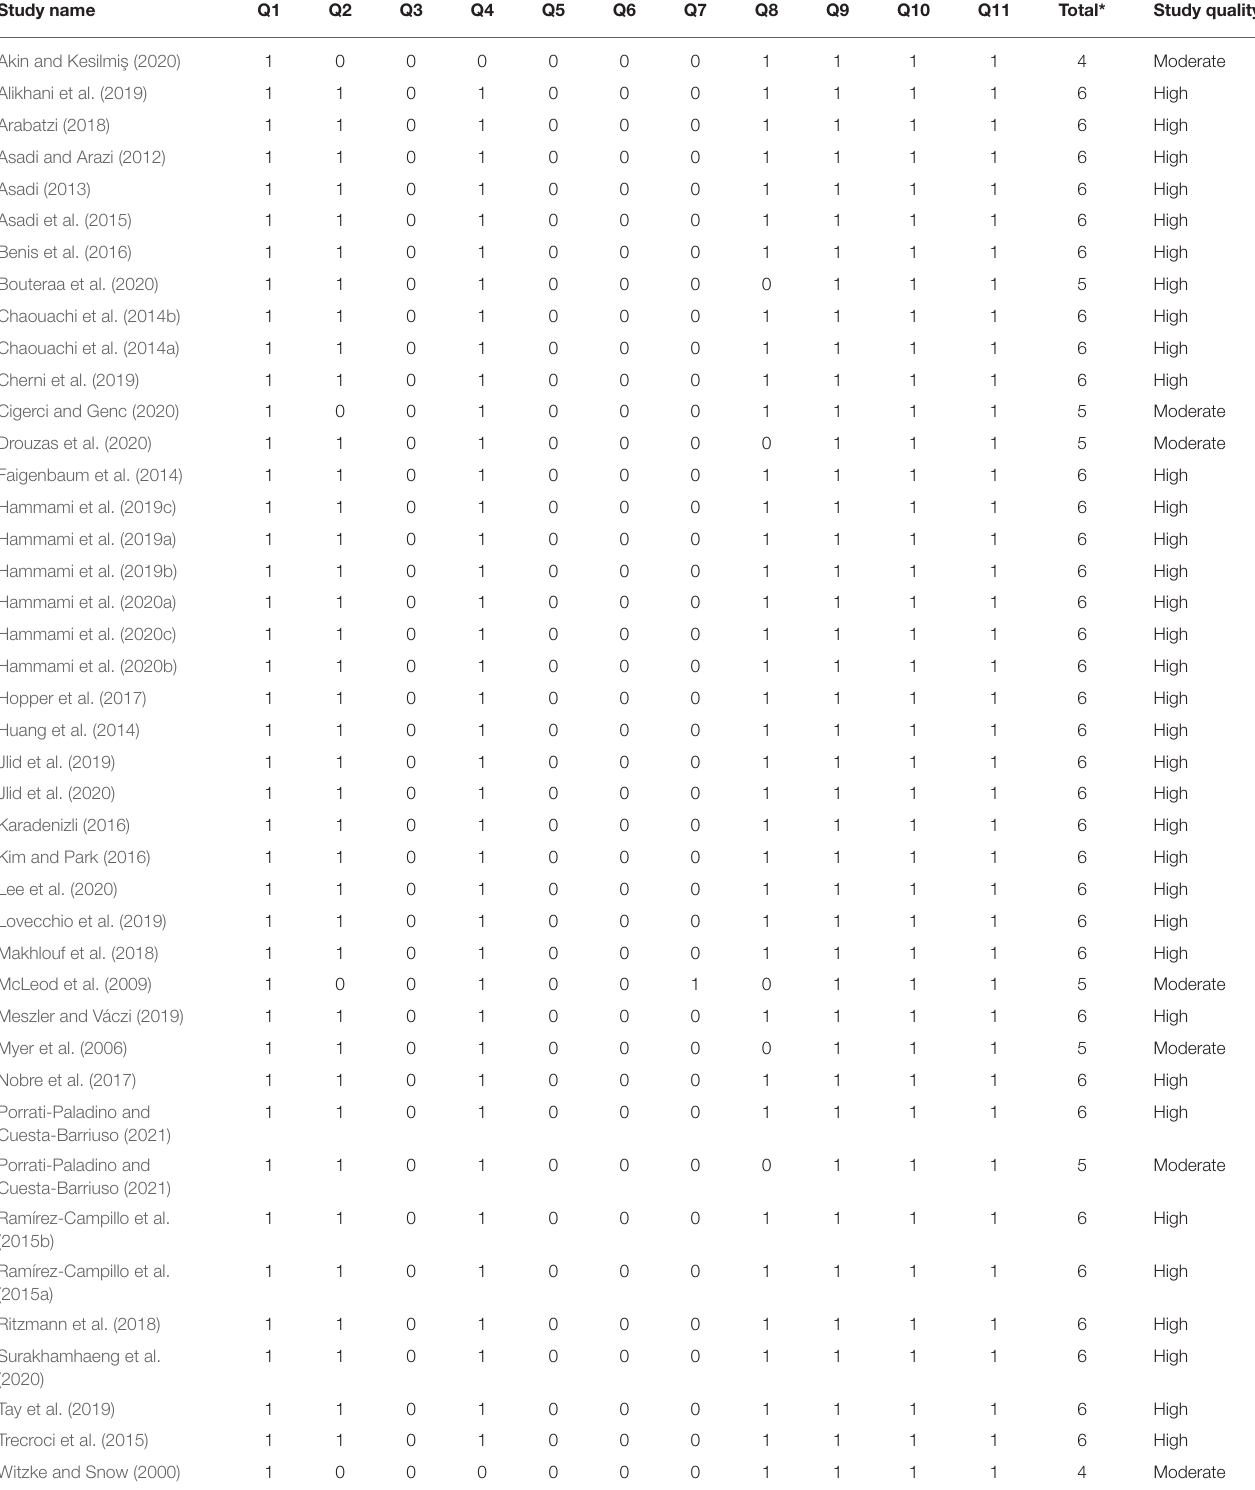
TABLE 4 | Methodological quality of the included studies using the PEDro rating